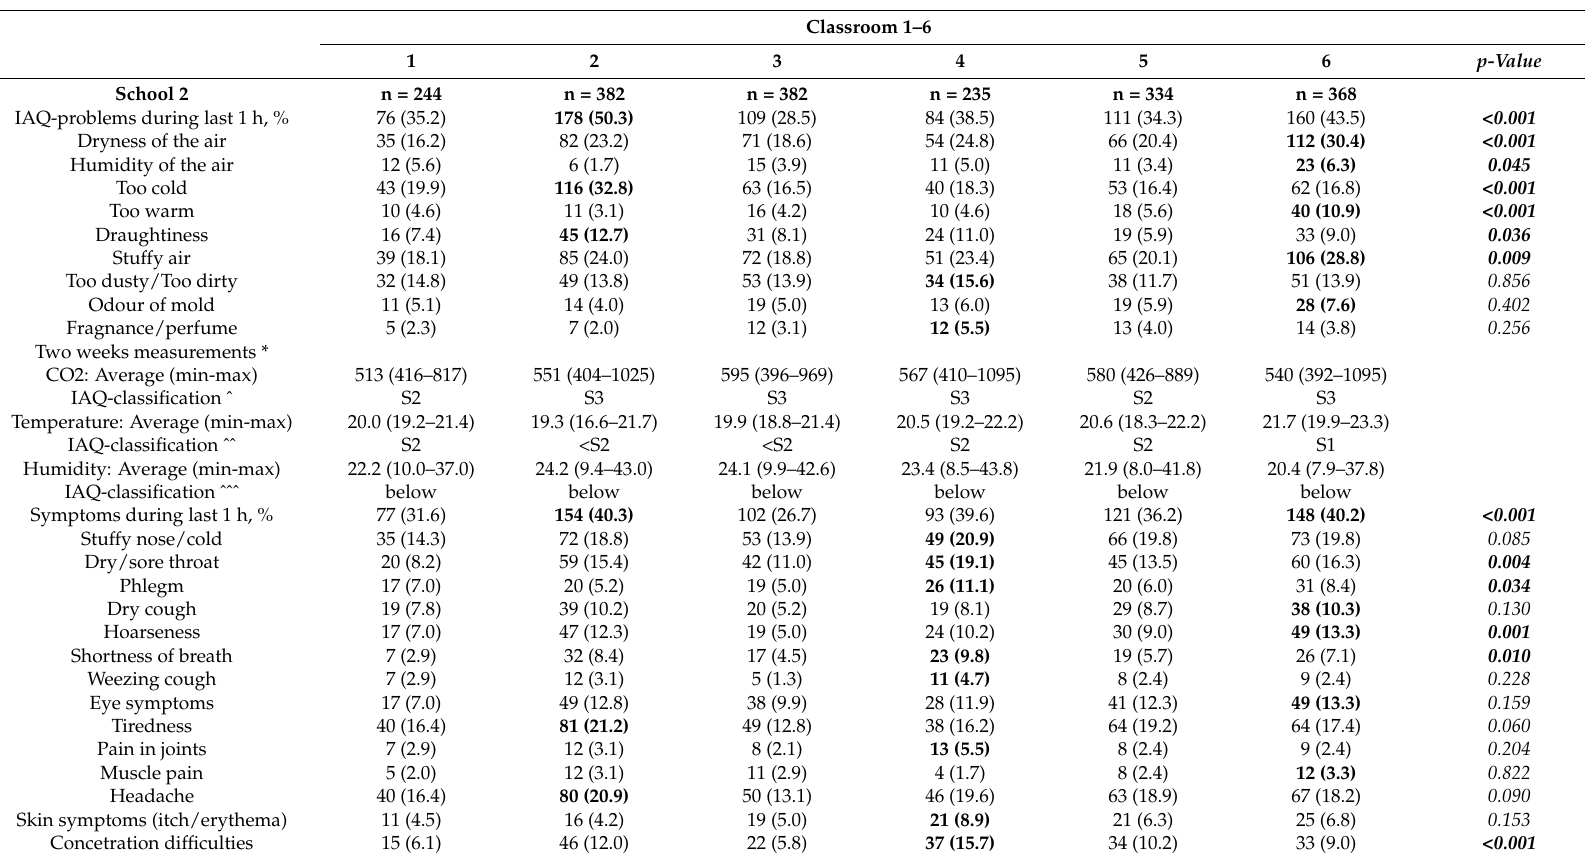
Table 5. Differences between the classrooms in the IAQ problems and symptoms during the last hour among pupils, and the results of CO 2 , temperature, and relative humidity measurements in school